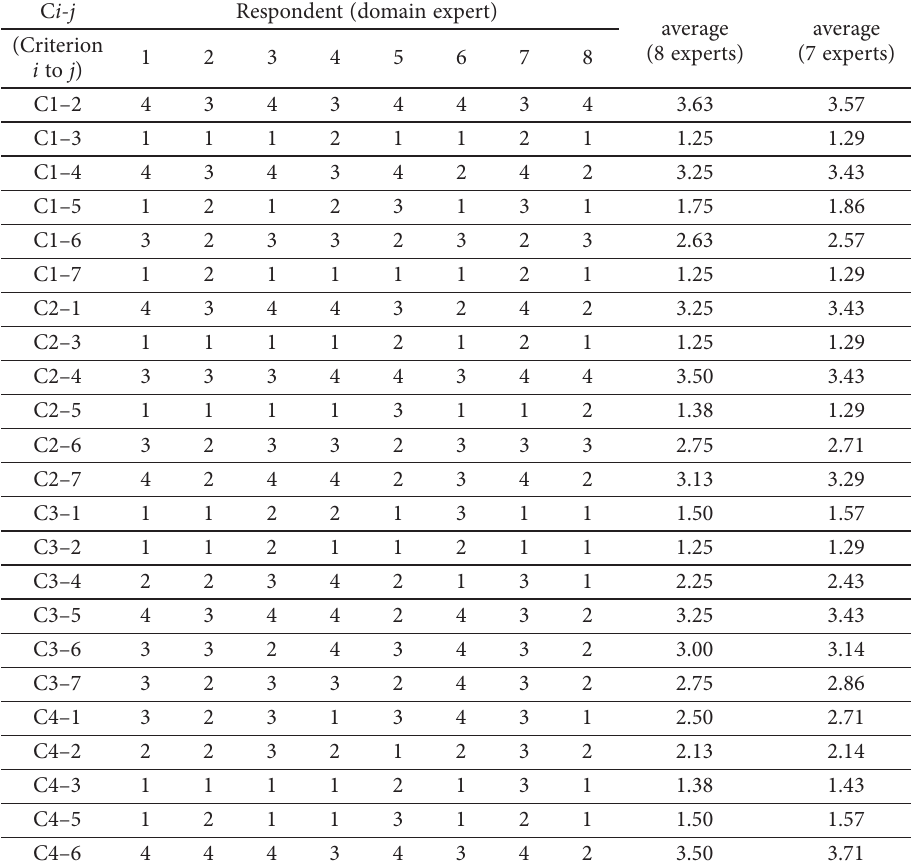
Table A1. Raw data from eight domain